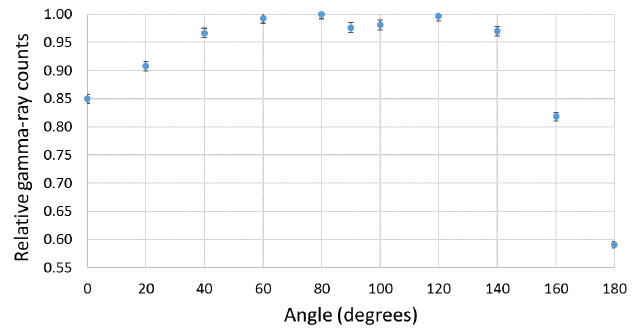
Figure 16. Gamma-ray detection efficiency varying the angle of a 0.11 MBq (2.86 µCi) 137 Cs source relative to the EJ-200 scintillator (source–detector distance is kept constant).